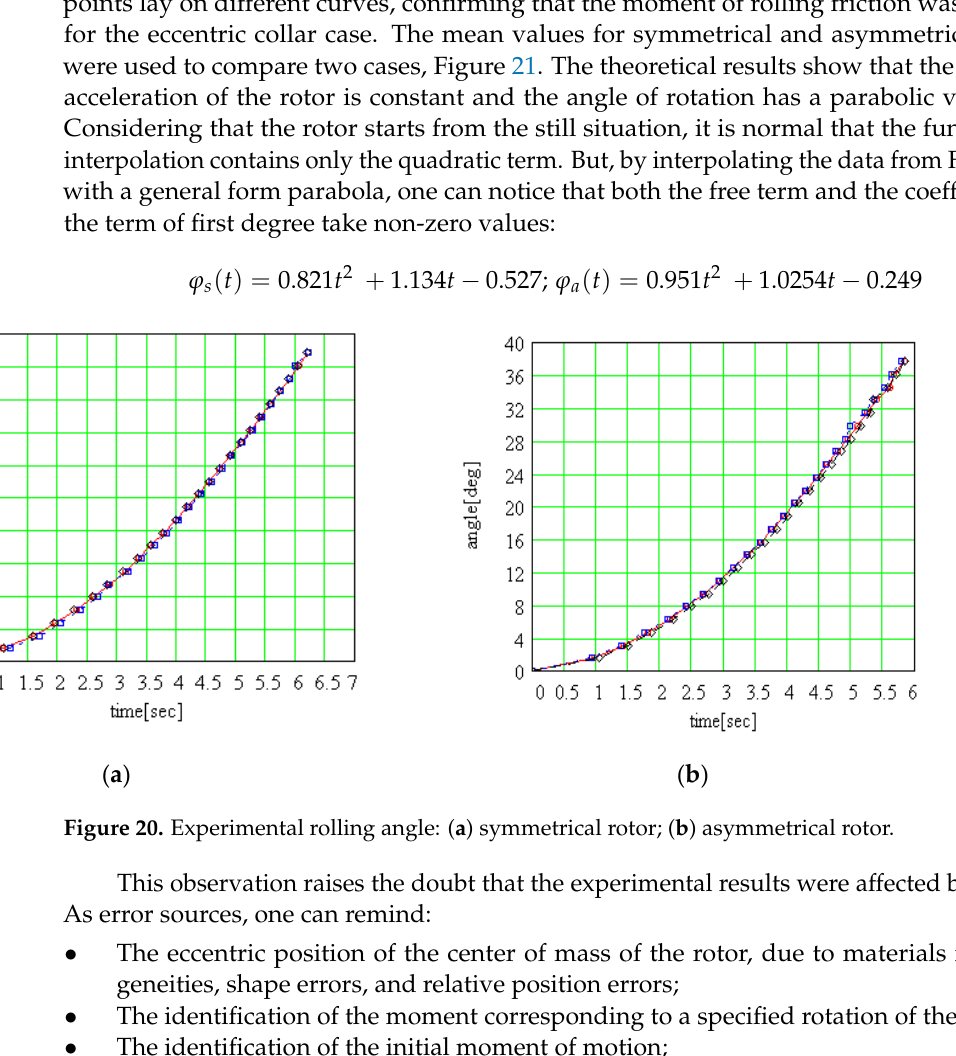
Figure 21. Time dependency of the rolling angle for the symmetrical and asymmetrical rotor. This observation raises the doubt that the experimental results were affected by er- rors. As error sources, one can remind: •